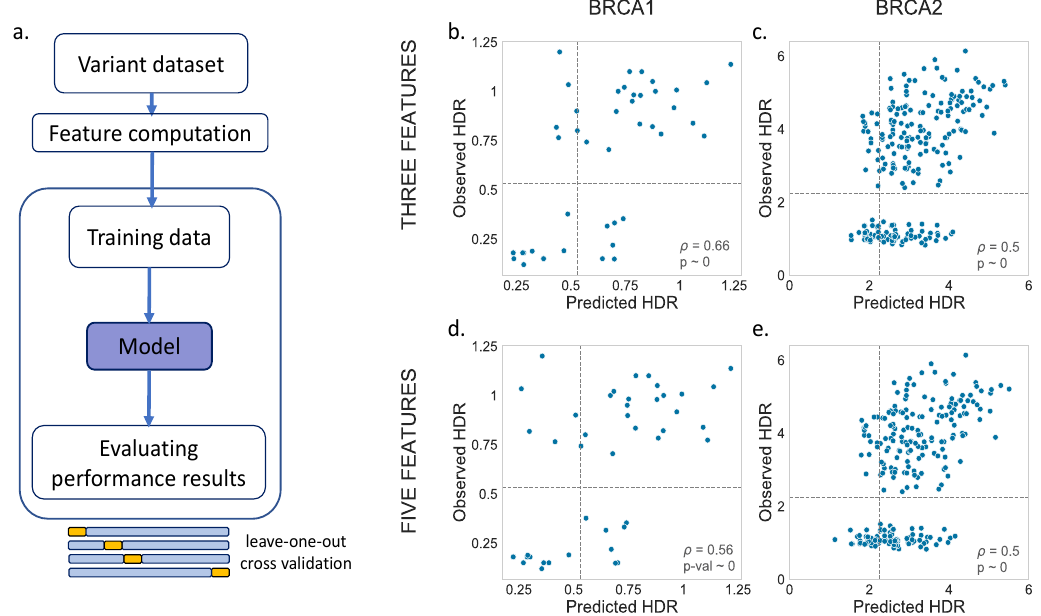
Figure 3. Observed vs. Predicted endophenotypes for the MLR model. When the endophenotypes are represented using the HDR functional assays, the small amount of data available for training purposes may prevent the training of the regularized models, like the Ridge, Lasso and Elastic. In this situation, that only affects BRCA1, we applied a training alternative to the scheme in Figure 2, following a rigorous LOOCV procedure ( a ). The results were obtained for two regression models: one with three (( b ) BRCA1 and ( c ) BRCA2) and another with five input features (( d ) BRCA1 and ( e ) BRCA2). The values of p , the Spearman’s Rank correlation, together with the corresponding p -values, are shown at the bottom-right of the figure. Note that the BRCA2 results are shown only for completeness, because there are enough variants for this protein to train the predictors according to the scheme in Figure 2. The dashed lines indicate the functionality thresholds, taken from the literature in the field and used in this work to binarize the endophenotype estimates into benign/pathogenic